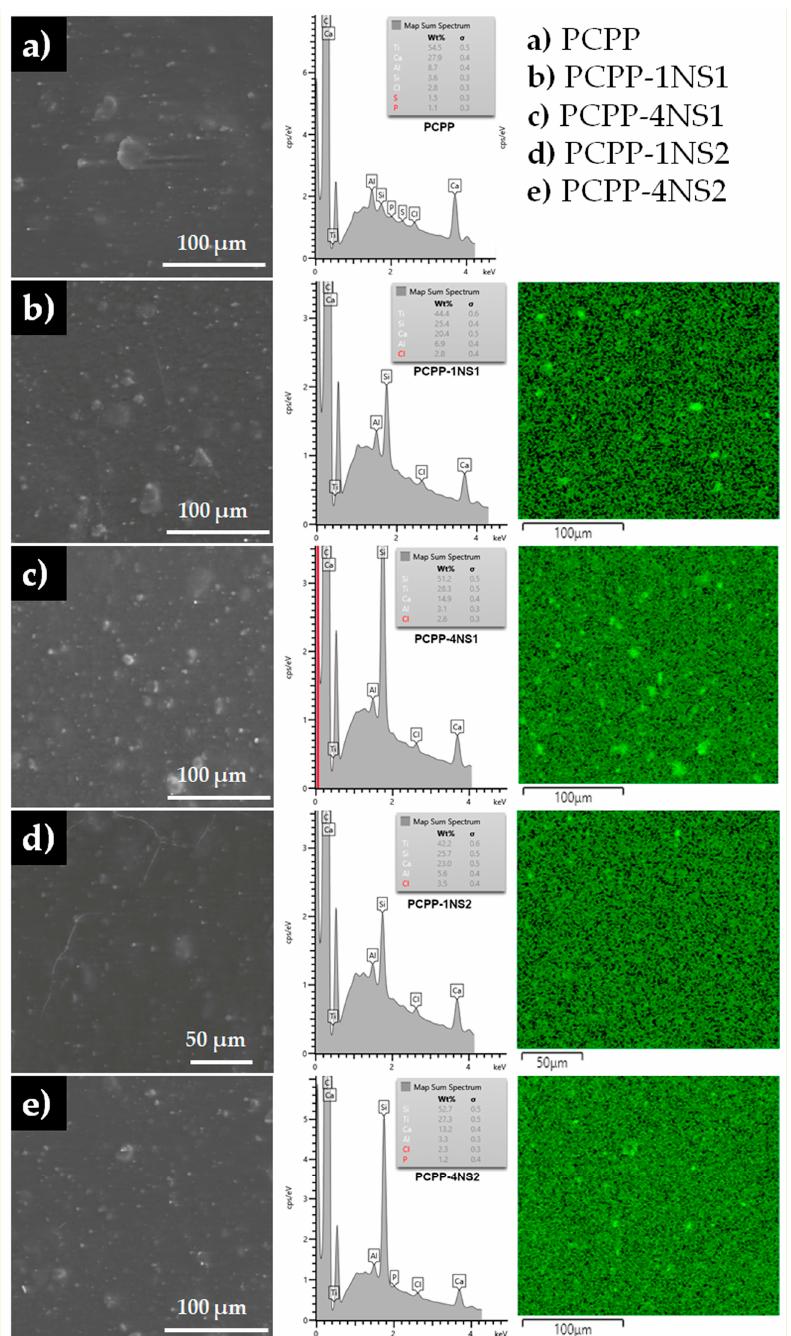
Figure 1. ESEM micrographs and EDS elemental mapping of ( a ) PCPP control and ( b – e ) nanocom- posite films. Left, middle and right columns show electron images of surface topography, map sum spectra of elements and EDS images for Si, respectively.